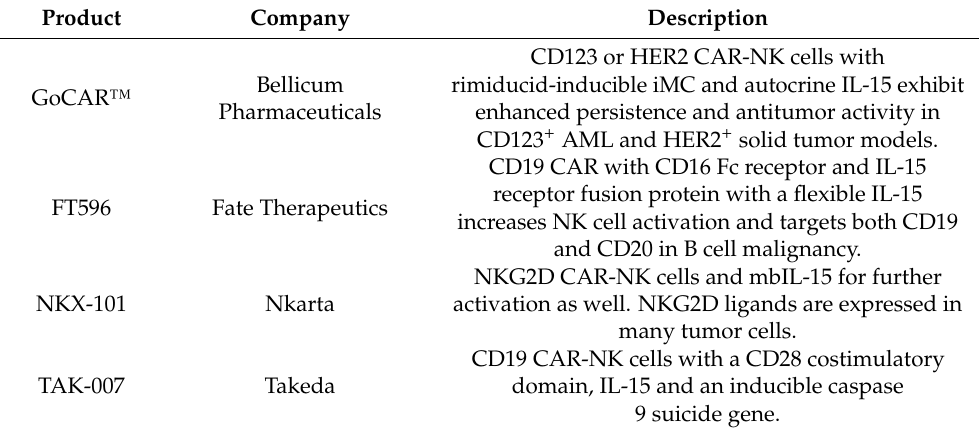
Table 1. Products in development using CAR-NK cells with onboard IL-15